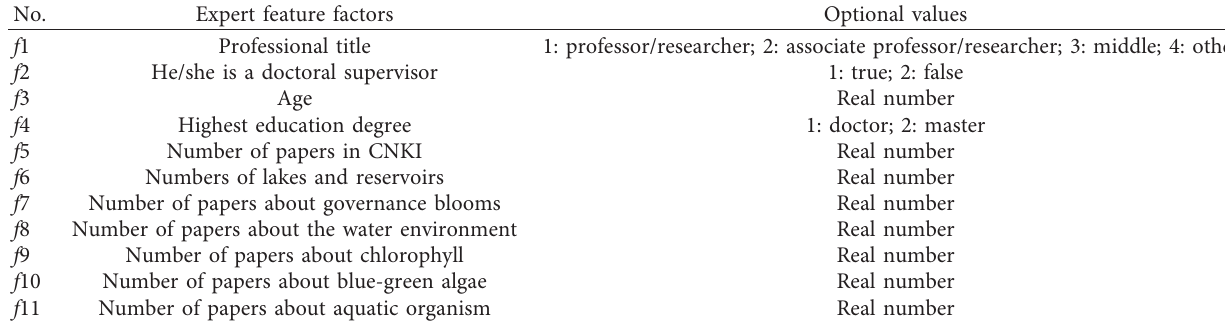
Table 1: Attribute names and their representations.